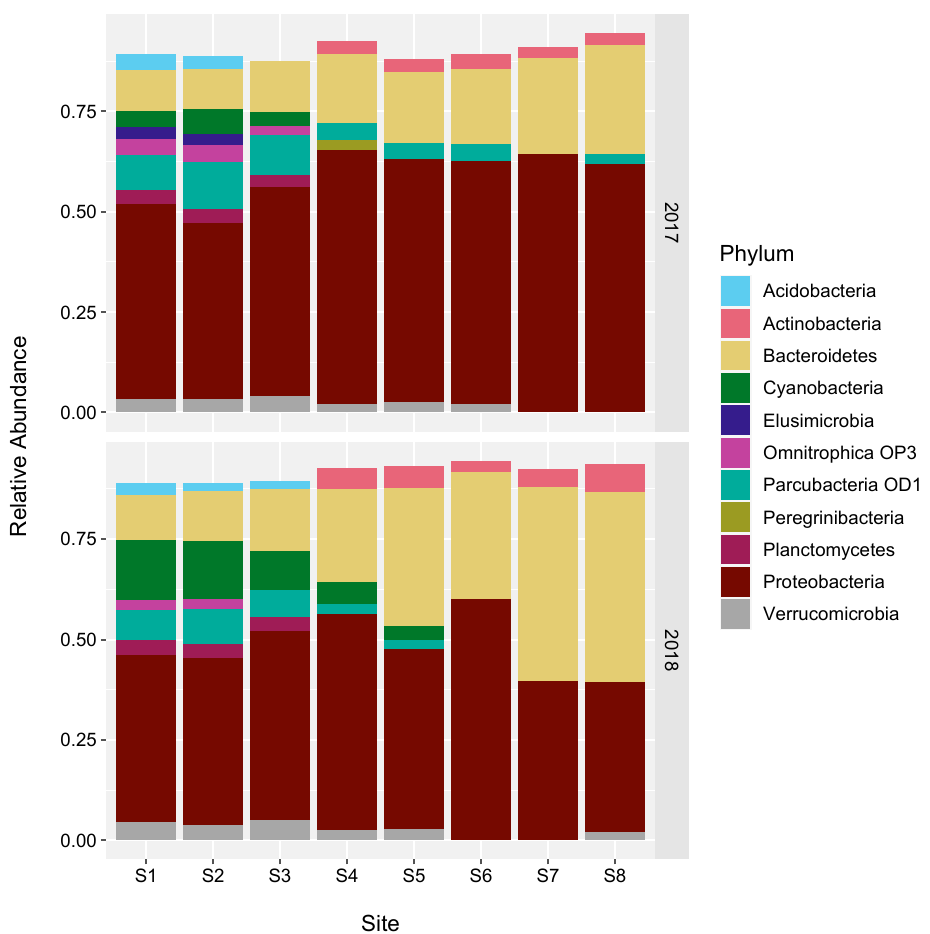
Figure 2. Relative abundance of bacterial phyla that are present at >2% in the populations at each site.